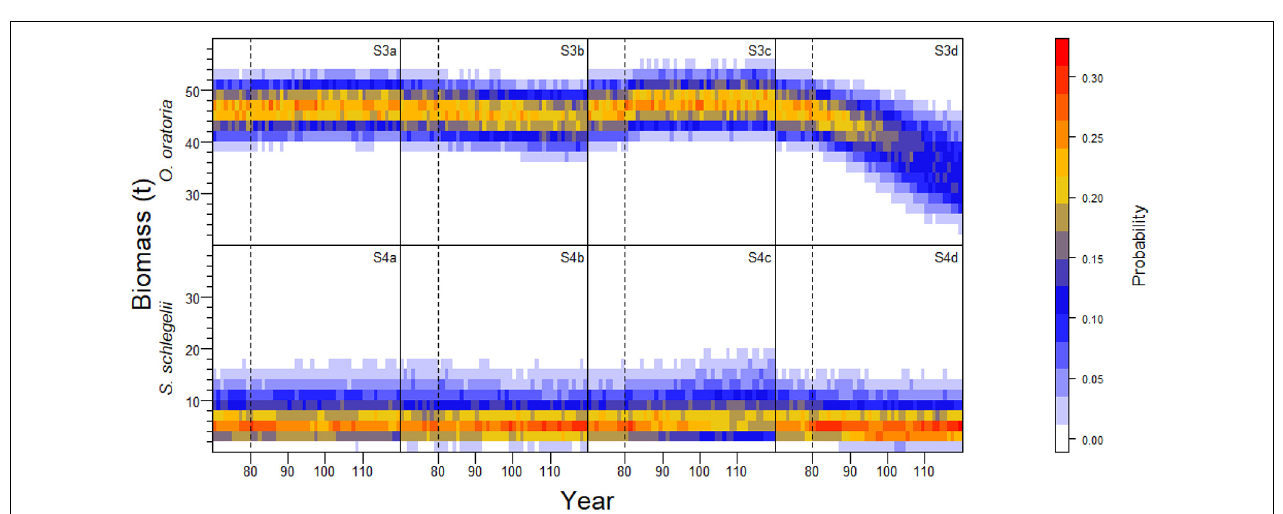
FIGURE 6 | Interannual probability frequency distribution of population biomass of O. oratoria and S. schlegelii with 1000 Monte Carlo simulation runs at the uncertainty level of fishing mortality rates specified for non-target species in each